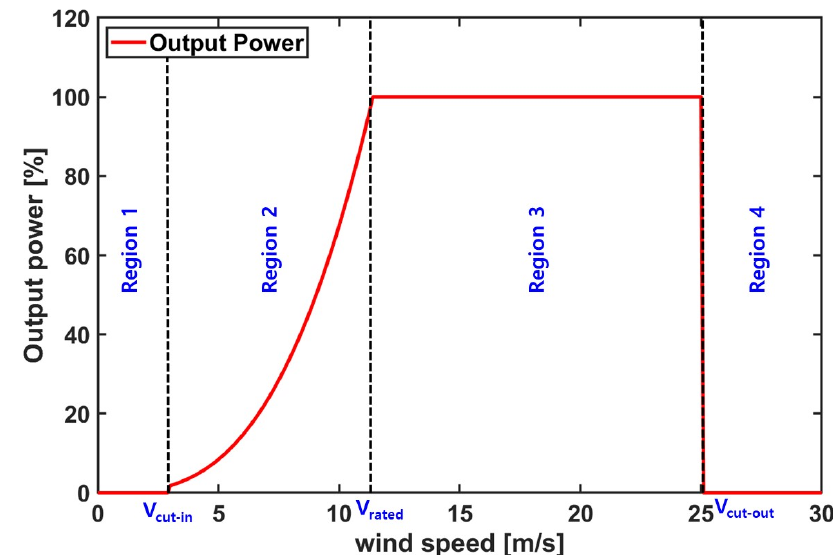
Figure 1. Wind turbine output characteristic curve based on wind speed.